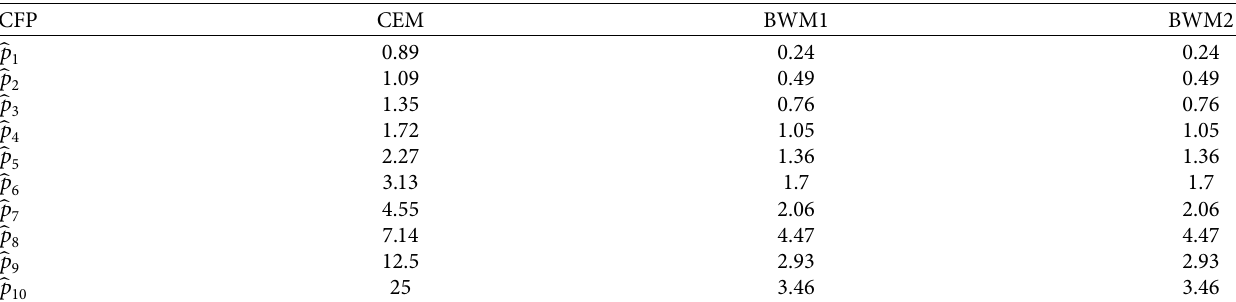
Figure 6: Relationship diagram between failure probability and parameter ( u ). Table 2: CFP estimation × 10 − 2 .